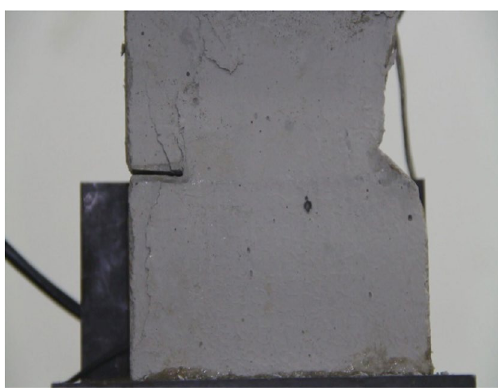
Figure 35. The same specimen shown in Fig. 33 at t = 2042s.